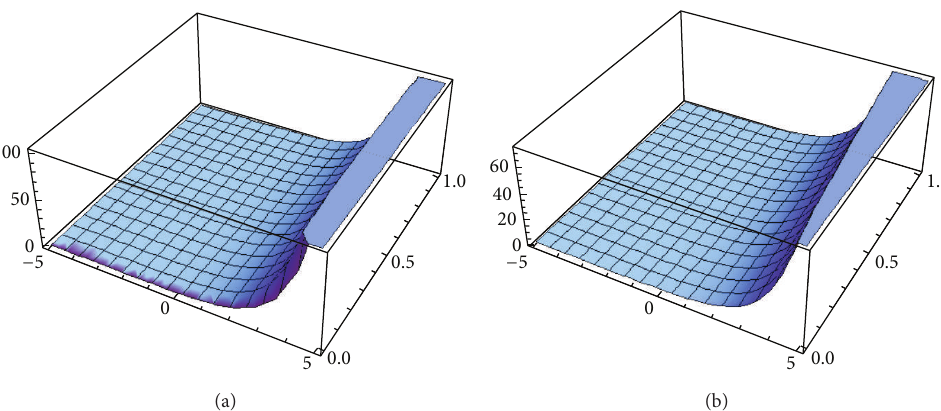
Figure 13: Graph of the solution (47) corresponding to the values 𝛼 = 0.05 , 𝛼 = 0.85 , respectively, when 𝑘 = 1 , 𝑎 0 = 1 , 𝑏 0 = 2 , −5 < 𝑥 < 5 , and 0 < 𝑡 < 1 .